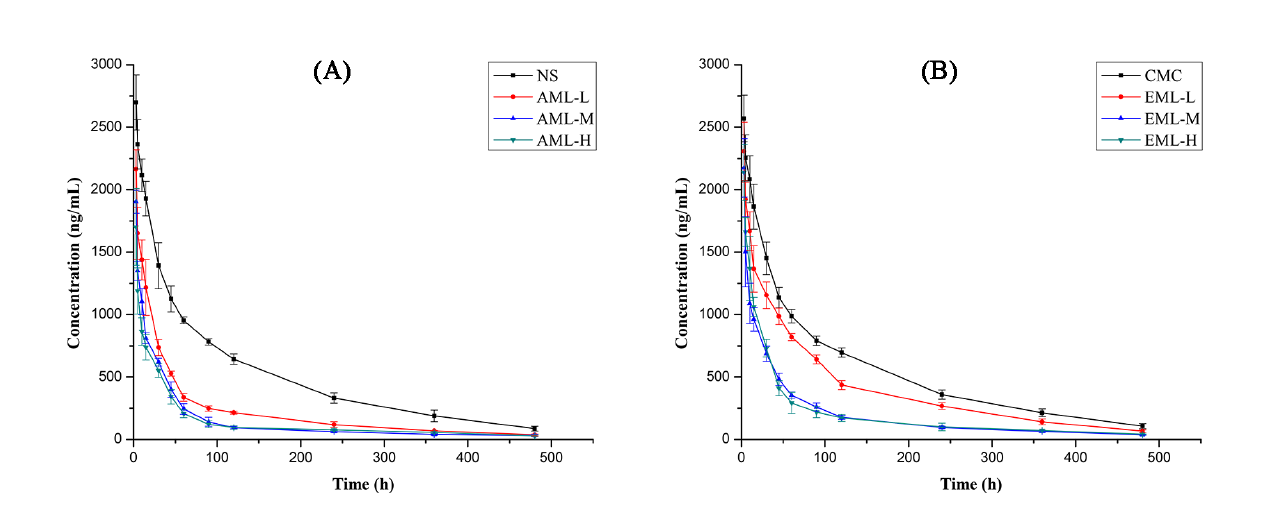
FIGURE 2 – Mean plasma concentration-time profiles of midazolam in rats pre-treated with AML (A) and EML (B).